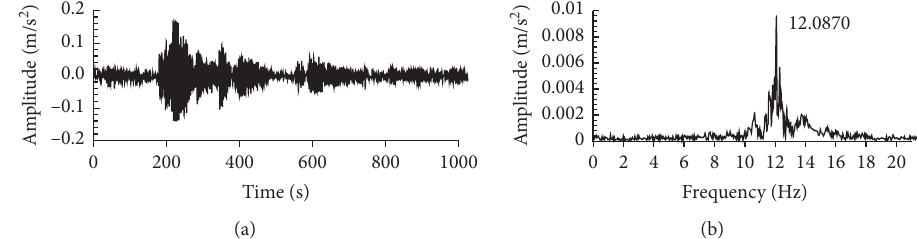
Figure 11: (a) Acceleration time-history curve of suspender with additional mass; (b) frequency spectrum with additional mass. Table 4: Parameters table of equivalent length calculation. Parameters